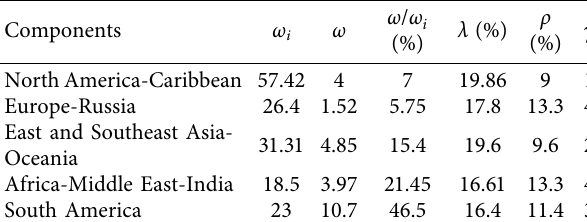
Table 3: Evolution of the weighted efciency and the LCC of the large local components after their isolation due to attacks based on strength. Te order of isolation of the components is also presented. ω i is the weighted efciency before attacks based on strength. ω is the weighted efciency after the separation. λ is the largest con- nected component size after the separation. ρ is the fraction of top strength nodes removed from the world air transportation network to isolate the component. c is the order in which the components are isolated. After their isolation, the components lose much of their